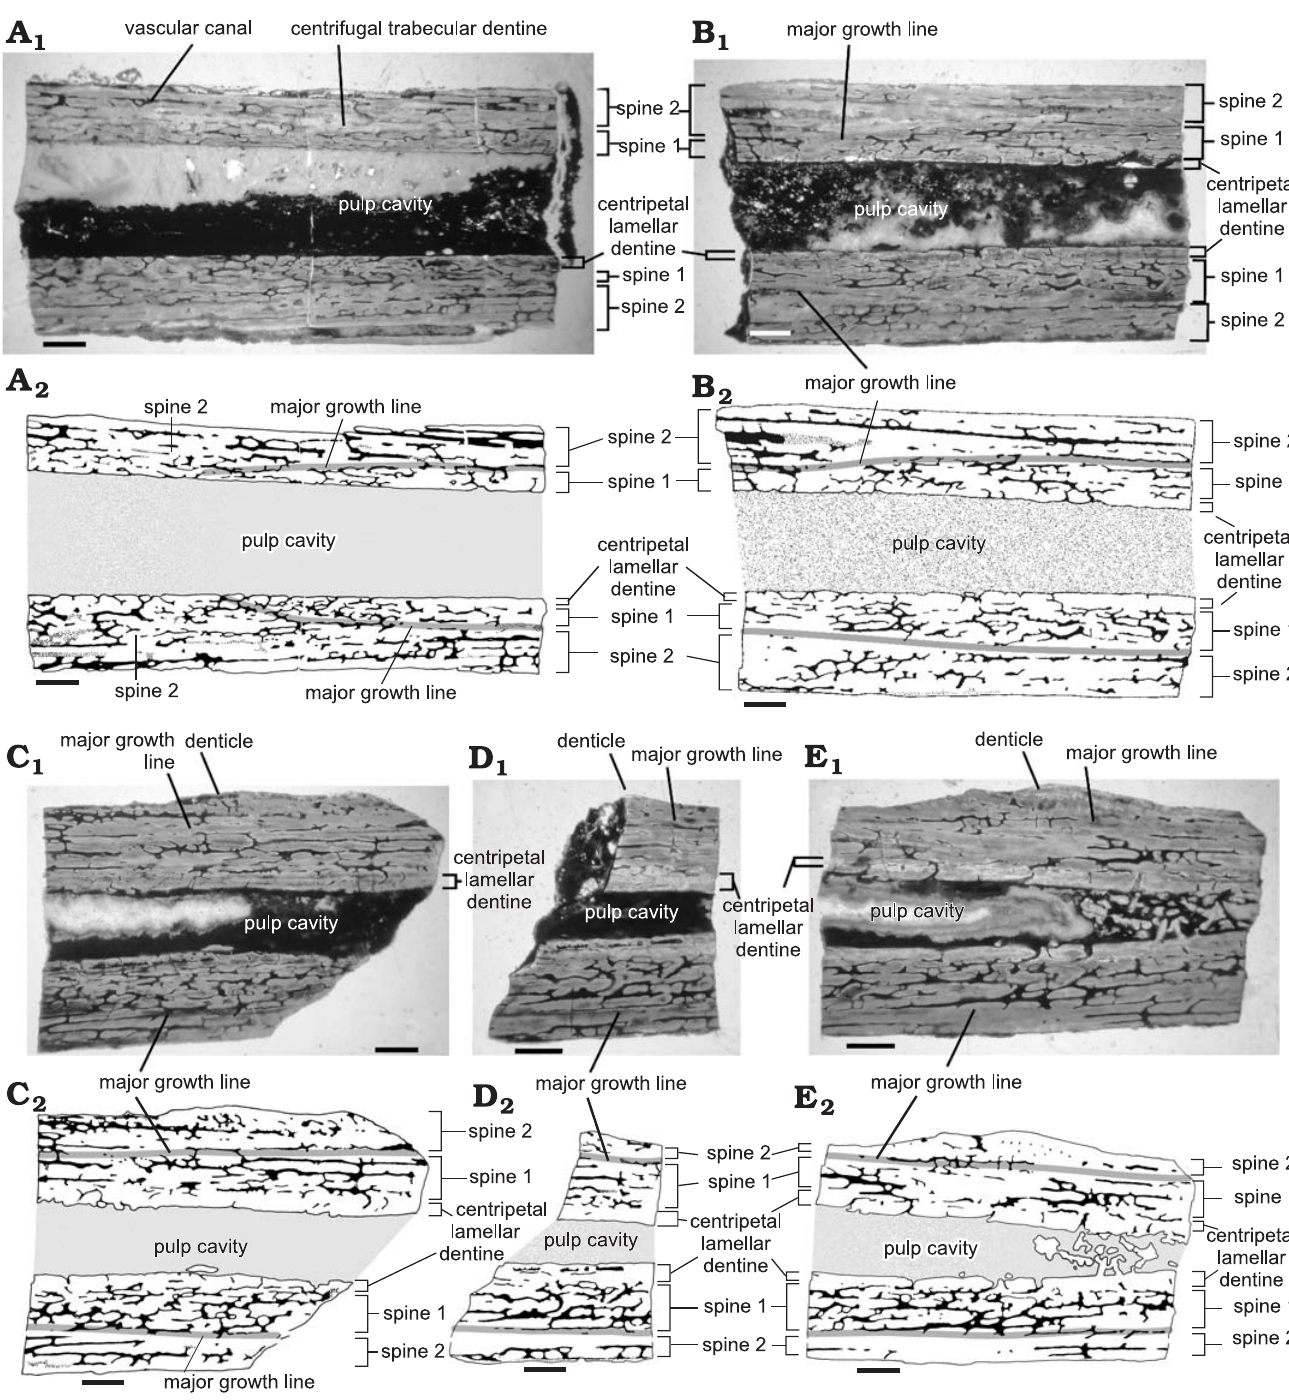
Fig. 4. Serial longitudinal sections of dorsal spine of Orthacanthus platypternus (Cope, 1884), Lower Permian, Craddock Bone Bed, Texas, USA; speci- men HMNS-T2, where A represents the most proximal section and E is the most distal. Samples C–E include the denticulate region. Photos of the sections (A 1 –E 1 ), interpretative drawings (A 2 –E 2 ). Scale bars 1